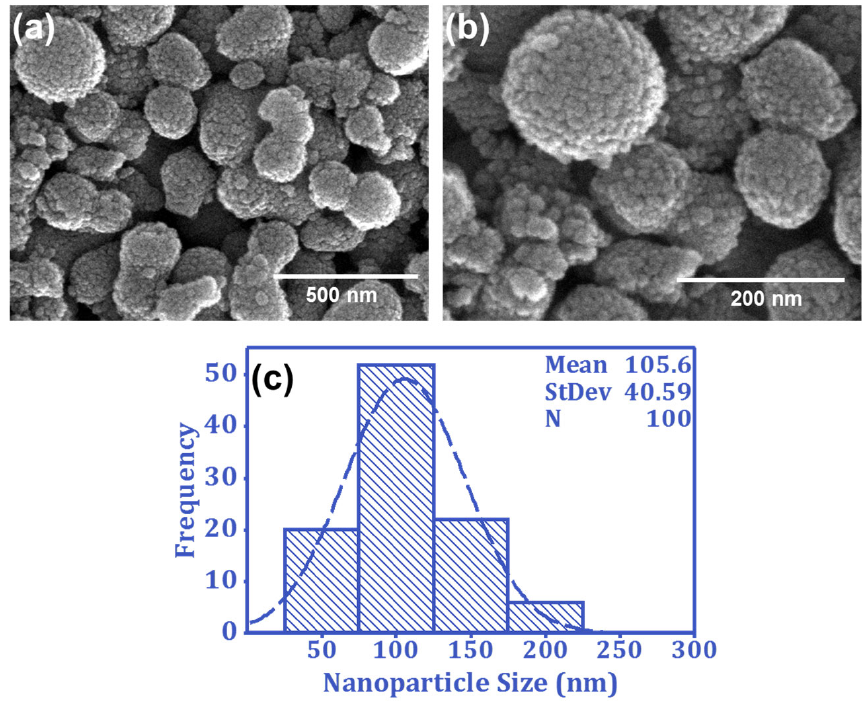
Figure 2. SEM images of bubble-structured SiO 2 -NPs at magni fi cations ( a ) 50,000 and ( b ) 100,000; ( c ) size distribution of SiO 2 -NPs. ( c ) size distribution of SiO 2